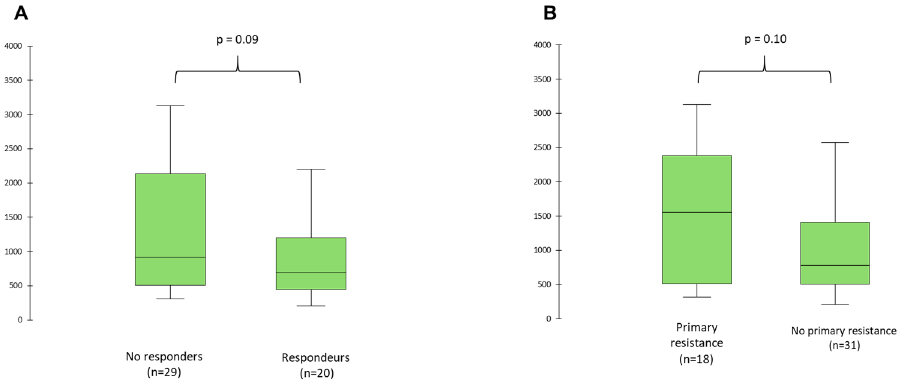
Figure 4. Wnt2 concentrations at baseline according to tumor response ( A ) and primary resistance ( B ).